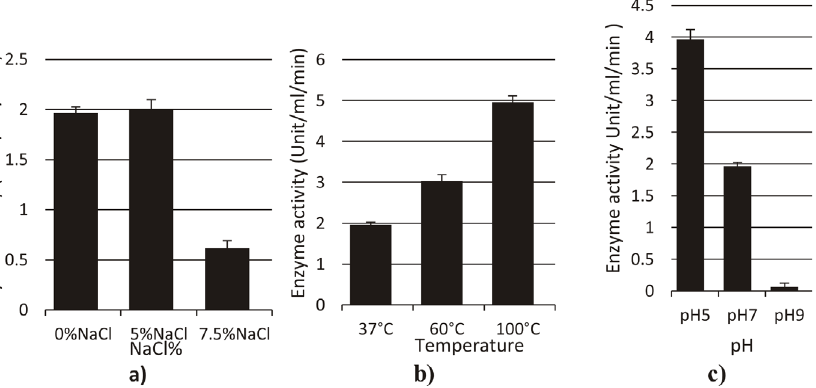
Fig. 5. Effect of different factors ( a : NaCl%, b : Temperature, c : pH) on the activity of amylase enzyme from Streptomyces